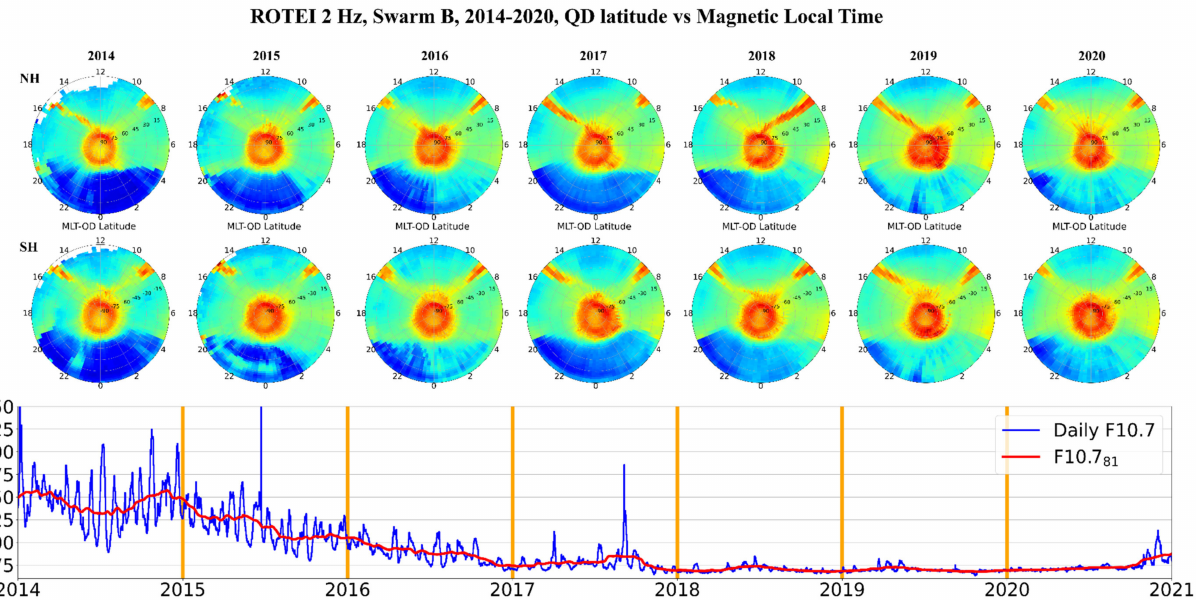
Figure 3. Statistical annual trends of ROTEI obtained from T e data measured by Swarm B from 2014 to 2020. Those represented are binned mean values in QD magnetic coordinates in polar projection; the bin size is (azimuth) 15 minutes in MLT, (radius) 2.5 ◦ in QD latitude. First row for the Northern hemisphere (NH), second row for the Southern hemisphere (SH). In the third row the time series of the F10.7 solar index (blue curve) and the corresponding 81 day running mean (F10.7 81 , red